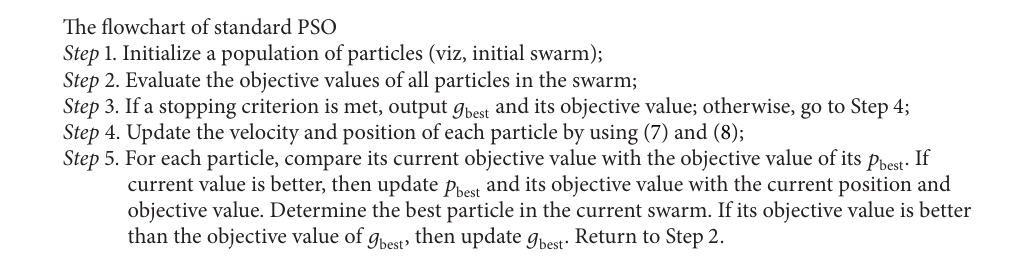
Algorithm 1: The flowchart of standard PSO.